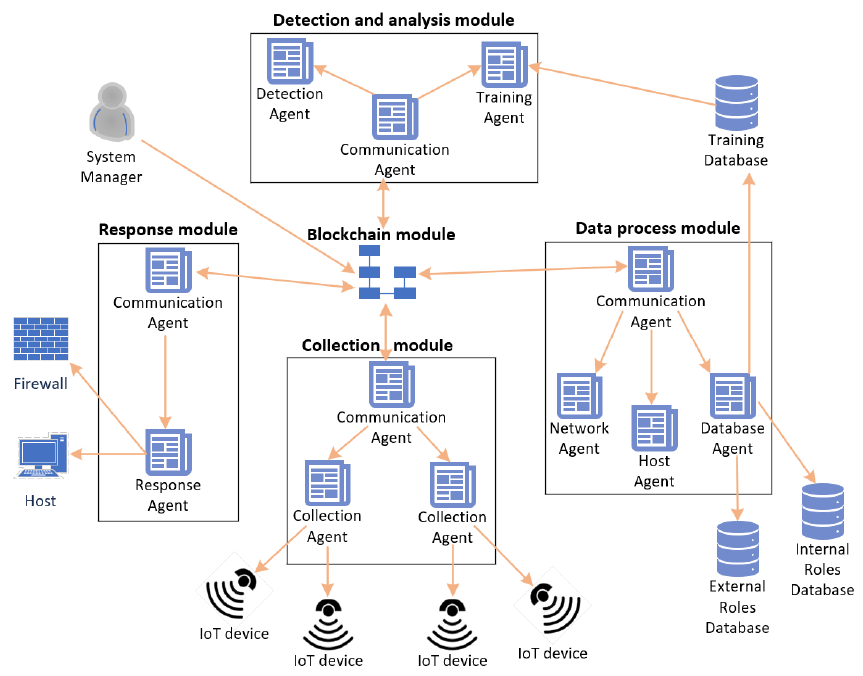
Figure 14. Architecture of the proposed system in